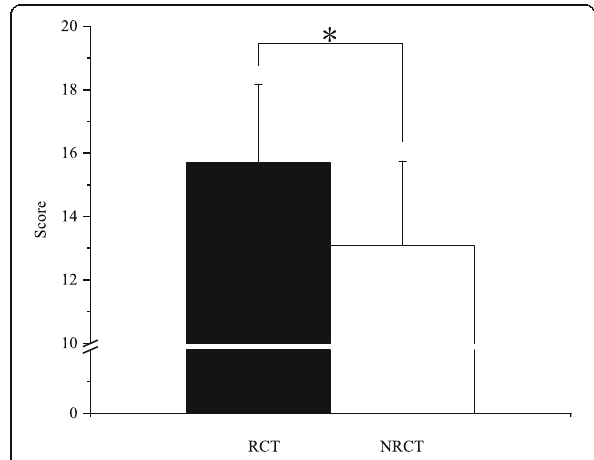
Fig. 4 Score of RCT ( n = 17) and NRCT ( n = 11), means ± SD, * p < 0.05, one-way analysis of variance